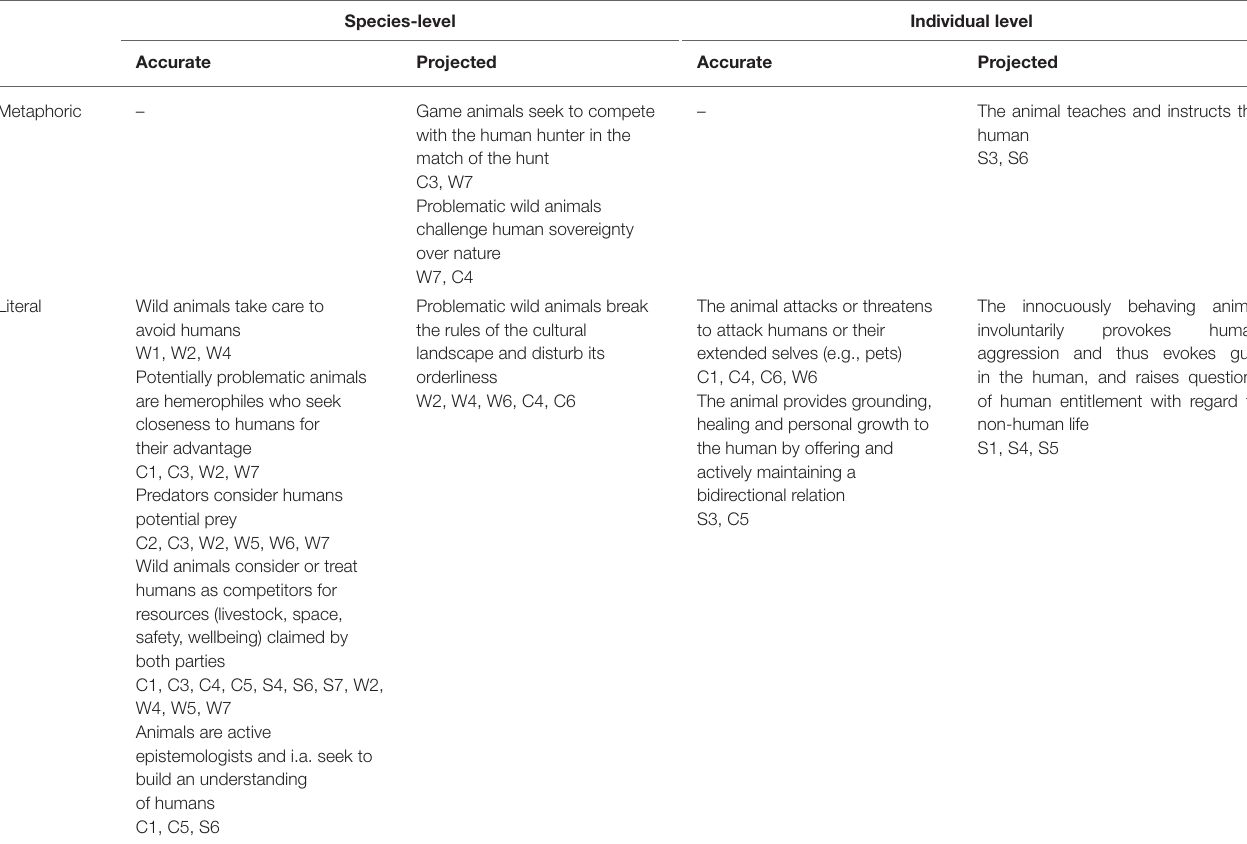
TABLE 1 | The 12 kinds of intentions attributed to wolves, corvids, and spiders, ordered according to the structure built by the 3 continua for analyzing the form of attributions. For each intention, the participants who stated it are listed below. Species-level Individual